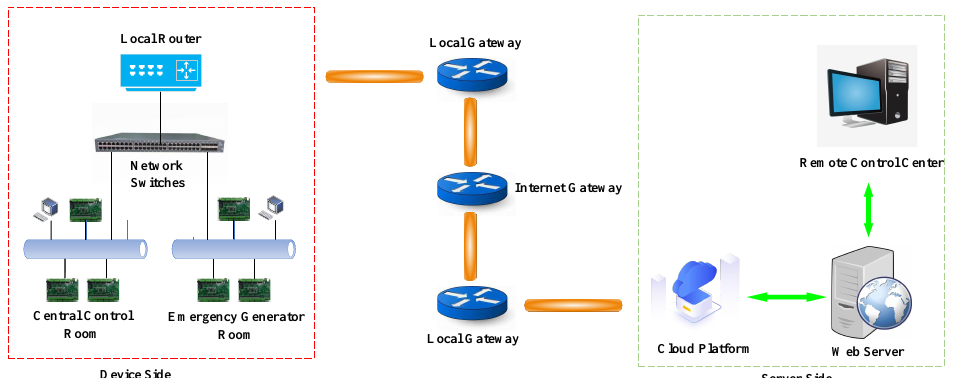
Figure 4. Network architecture of the remote upgrade system.